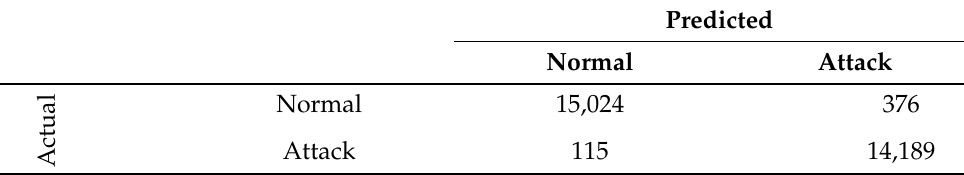
Table 9. Confusion matrix for NSL-KDD “class weights” binary classification